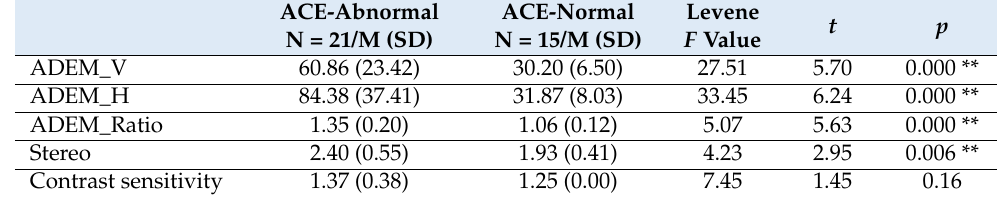
Table 3. Independent t -test of visual function between ACE-normal and -abnormal subjects.